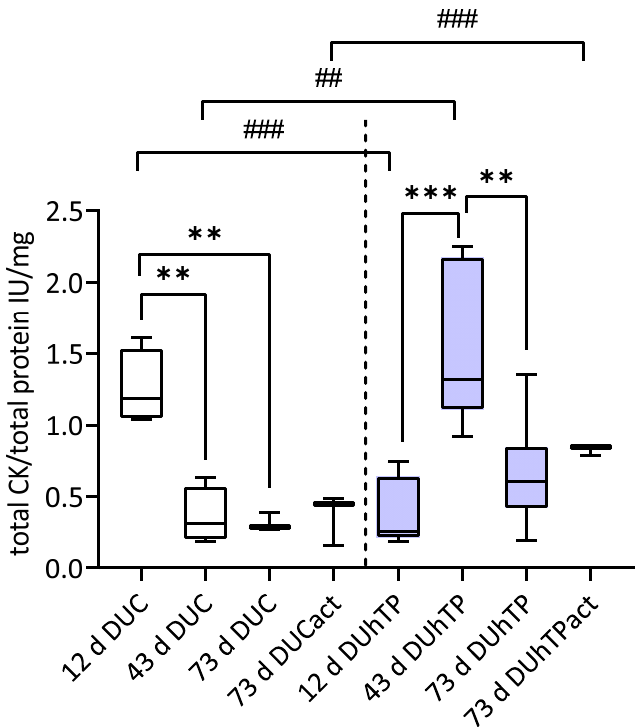
Figure 7. The activity of cellular creatine kinase in myotubes derived from male sedentary DUC (left, 12 d and 43 d: n = 4 mice, 73 d and 73 d act: n = 3 mice) and DUhTP mice (right, 12 d and 73 d: n = 7 mice, 43 d: n = 5 mice, and 73 d act: n = 3 mice) at the age of 12, 43, and 73 days (d) or physically active (act) 73-day old mice. Creatine kinase activity was determined 72 h after induction of differentiation. Results were obtained from quadruplicates, and total CK activity per total cell protein was calculated and displayed as means ± SD. Statistical significances were calculated by one-way ANOVA. Significant line-specific differences between DUC and DUhTP lines are separated by hashtags ( ## p < 0.01, ### p < 0.001), while significant age-related differences within each line are separated by asterisks (** p <0.01, *** p < 0.001).